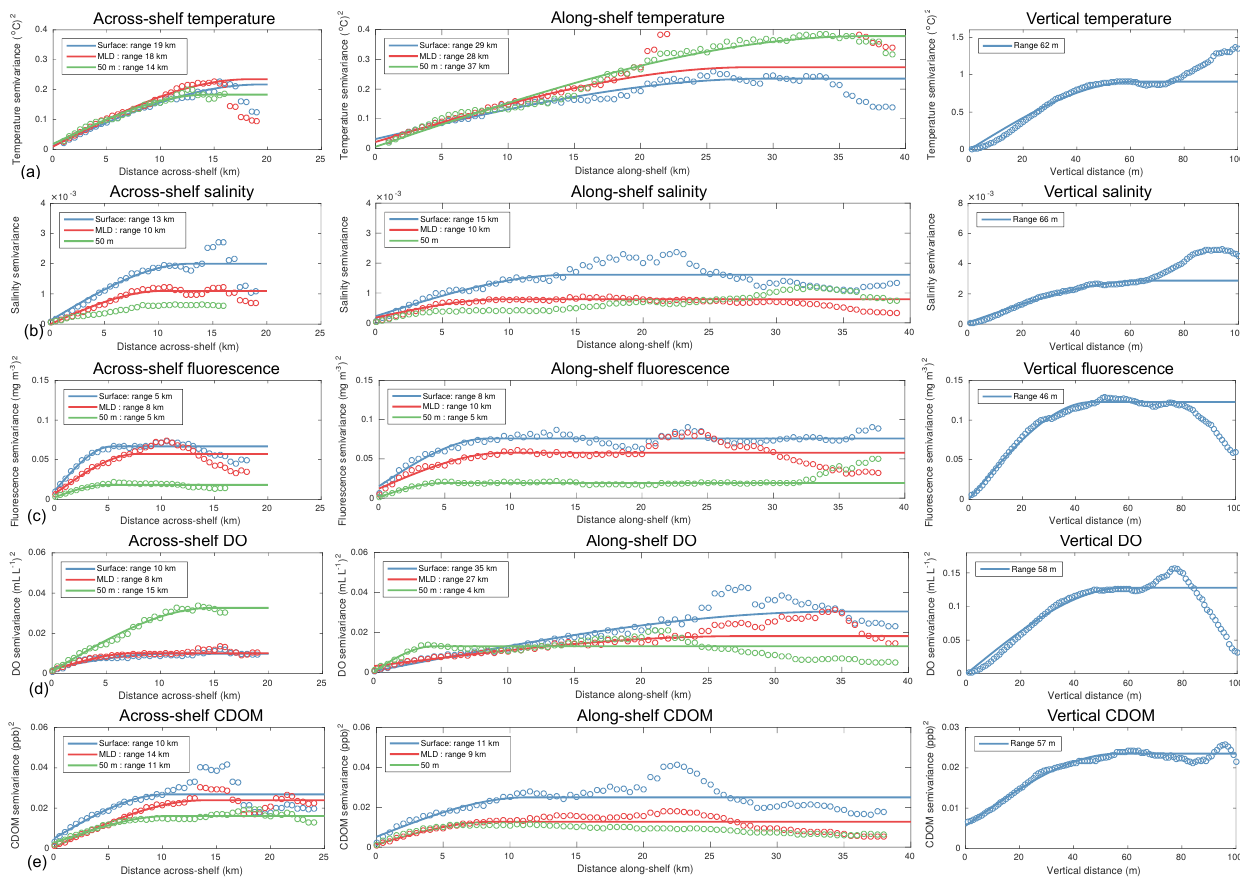
Figure 3. Cross-shelf (left), along-shelf (middle) and vertical (right) empirical semivariograms estimated from glider measurements of (a) temperature, (b) salinity, (c) chlorophyll a fluorescence, (d) DO, and (e) CDOM. Spherical models are shown by the solid lines and the resulting spatial ranges are indicated in the insert for successful fits. Blue, red, green symbols for horizontal semivariograms correspond to surface (0–5m), MLD (5–30m), and 50m measurements,